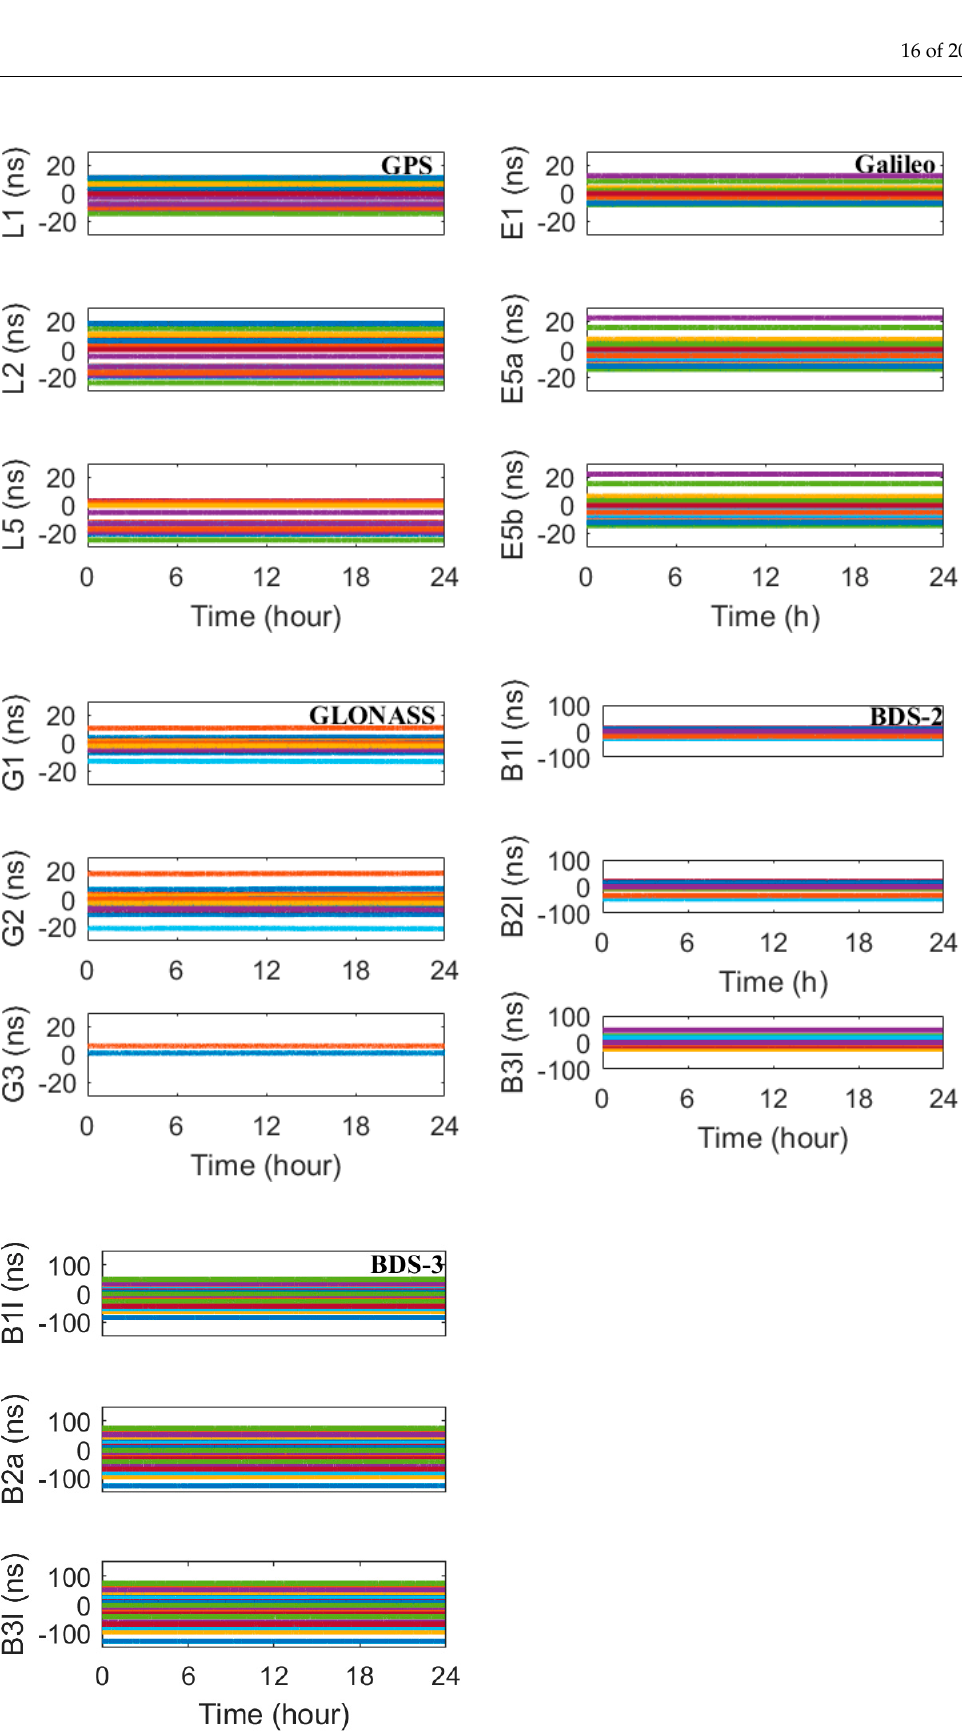
Figure 7. The multi-GNSS phase OSB series on DOY 290, 2021. A different color line represents a different